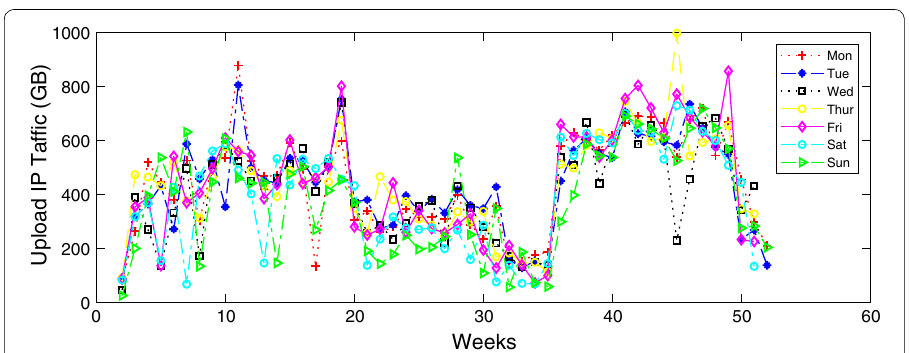
Fig. 4 Internet upload traffic variations across the 51